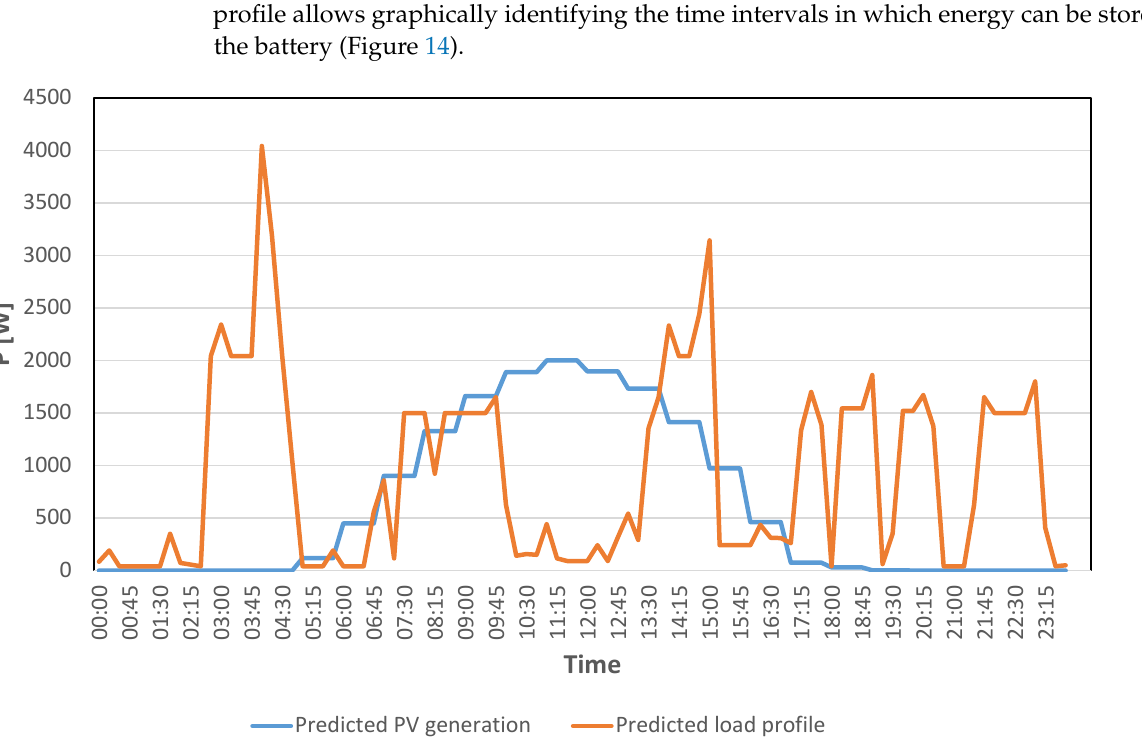
Figure 14. Comparison between predicted load diagram and predicted PV production.